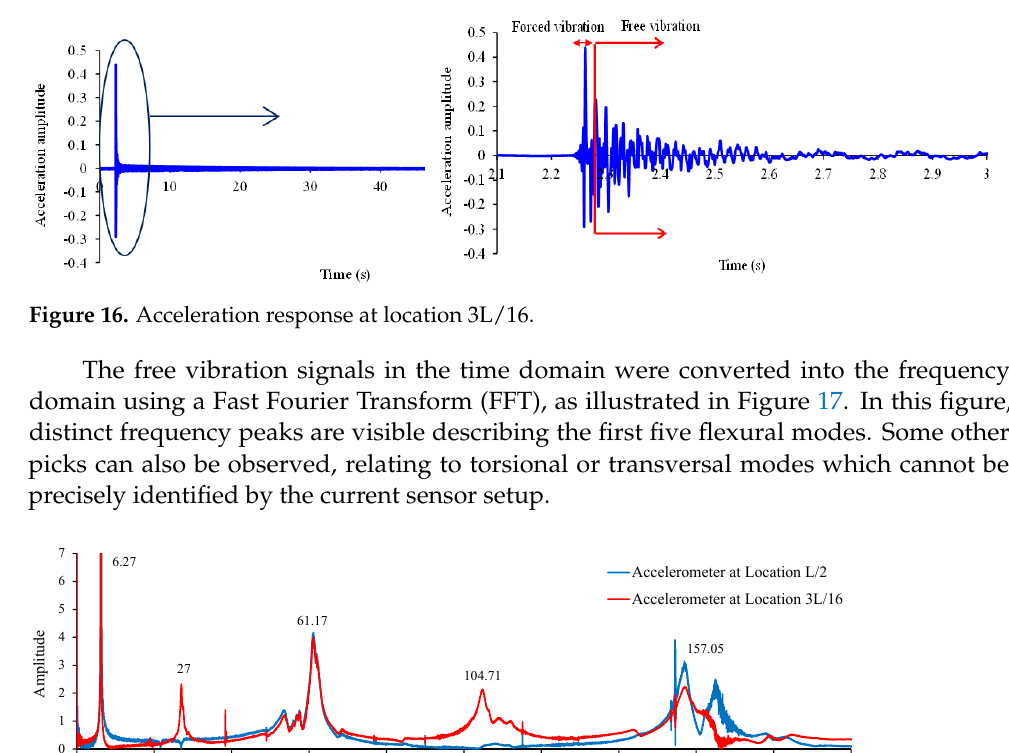
Figure 17. FFT of acceleration responses at locations L/2 and 3L/16.